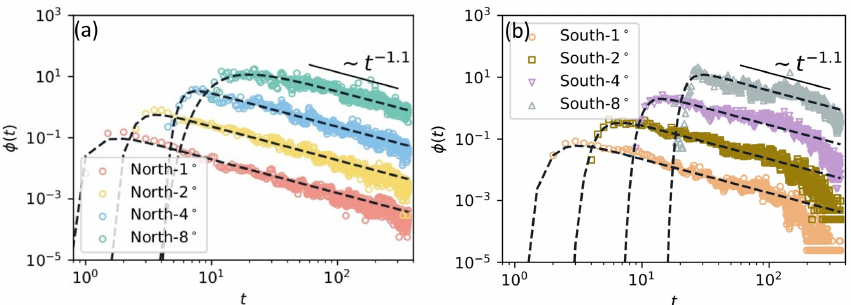
Figure 9. Comparison of the first passage time distribution of the fractional Brownian motion model (see Eq. (4)) with the empirical data for the (a) northern subset and (b) southern subset of advected parcels. Note that, to allow better visual comparison of the data to the fBm model, the values are multiplied by a factor of 10 for 2 ◦ , a factor of 100 for 4 ◦ and a factor of 1000 for 8 ◦ .